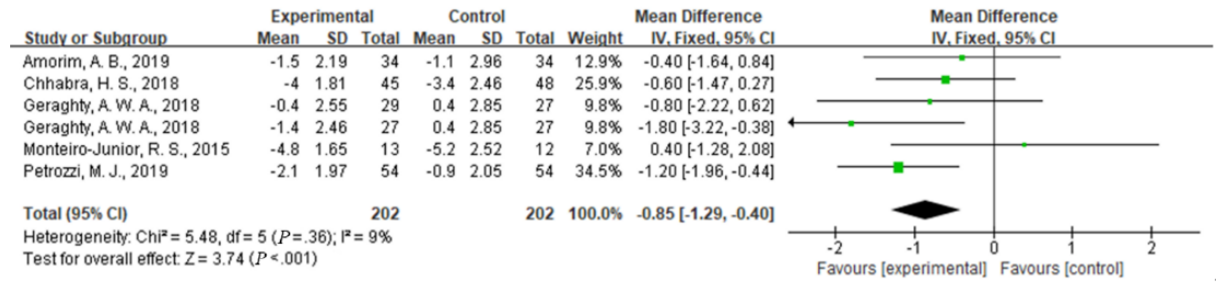
Figure 3. Forest plot of the efficacy of mobile health and traditional health interventions in reducing pain intensity.